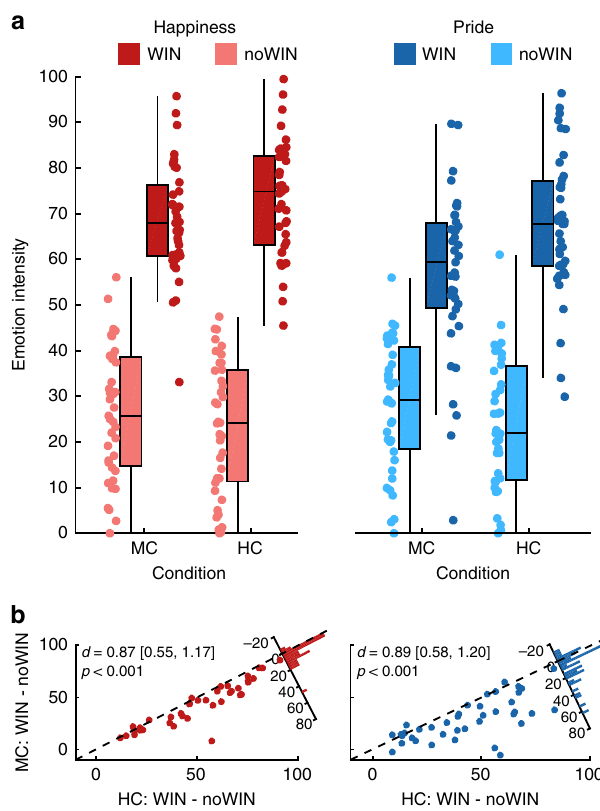
Fig. 3 Task effects on emotion ratings in study 2. a Emotion ratings, separate for pride and happiness, high and medium control as well as outcome valence. b Scatterplots depict reactivity to WIN vs noWIN outcomes for happiness (left) and pride (right) in dependence of internal control condition ( x -axis: HC; y -axis: MC). Histograms in top right corners visualize the differences in emotion reactivity between HC and MC. HC high control, MC medium control. d = Cohen ’ s d . Values in brackets represent 90% con fi dence intervals for d . The center line of boxplots depicts the median, the upper and lower box borders are the 25th and 75th percentile, and the length of the whiskers is 1.5 times the interquartile range. Source data are provided as a Source Data fi